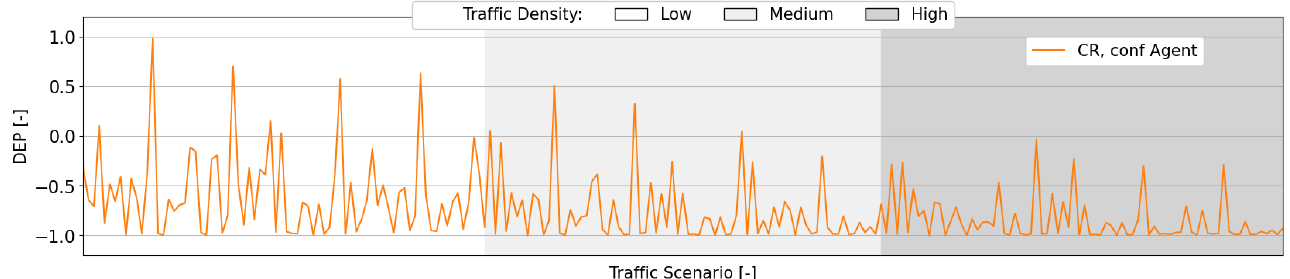
Figure 21. Domino effect parameter values. All traffic densities have 75 traffic scenarios, with the initial direction(s) and the number of turns following the same order as shown during the training phase.